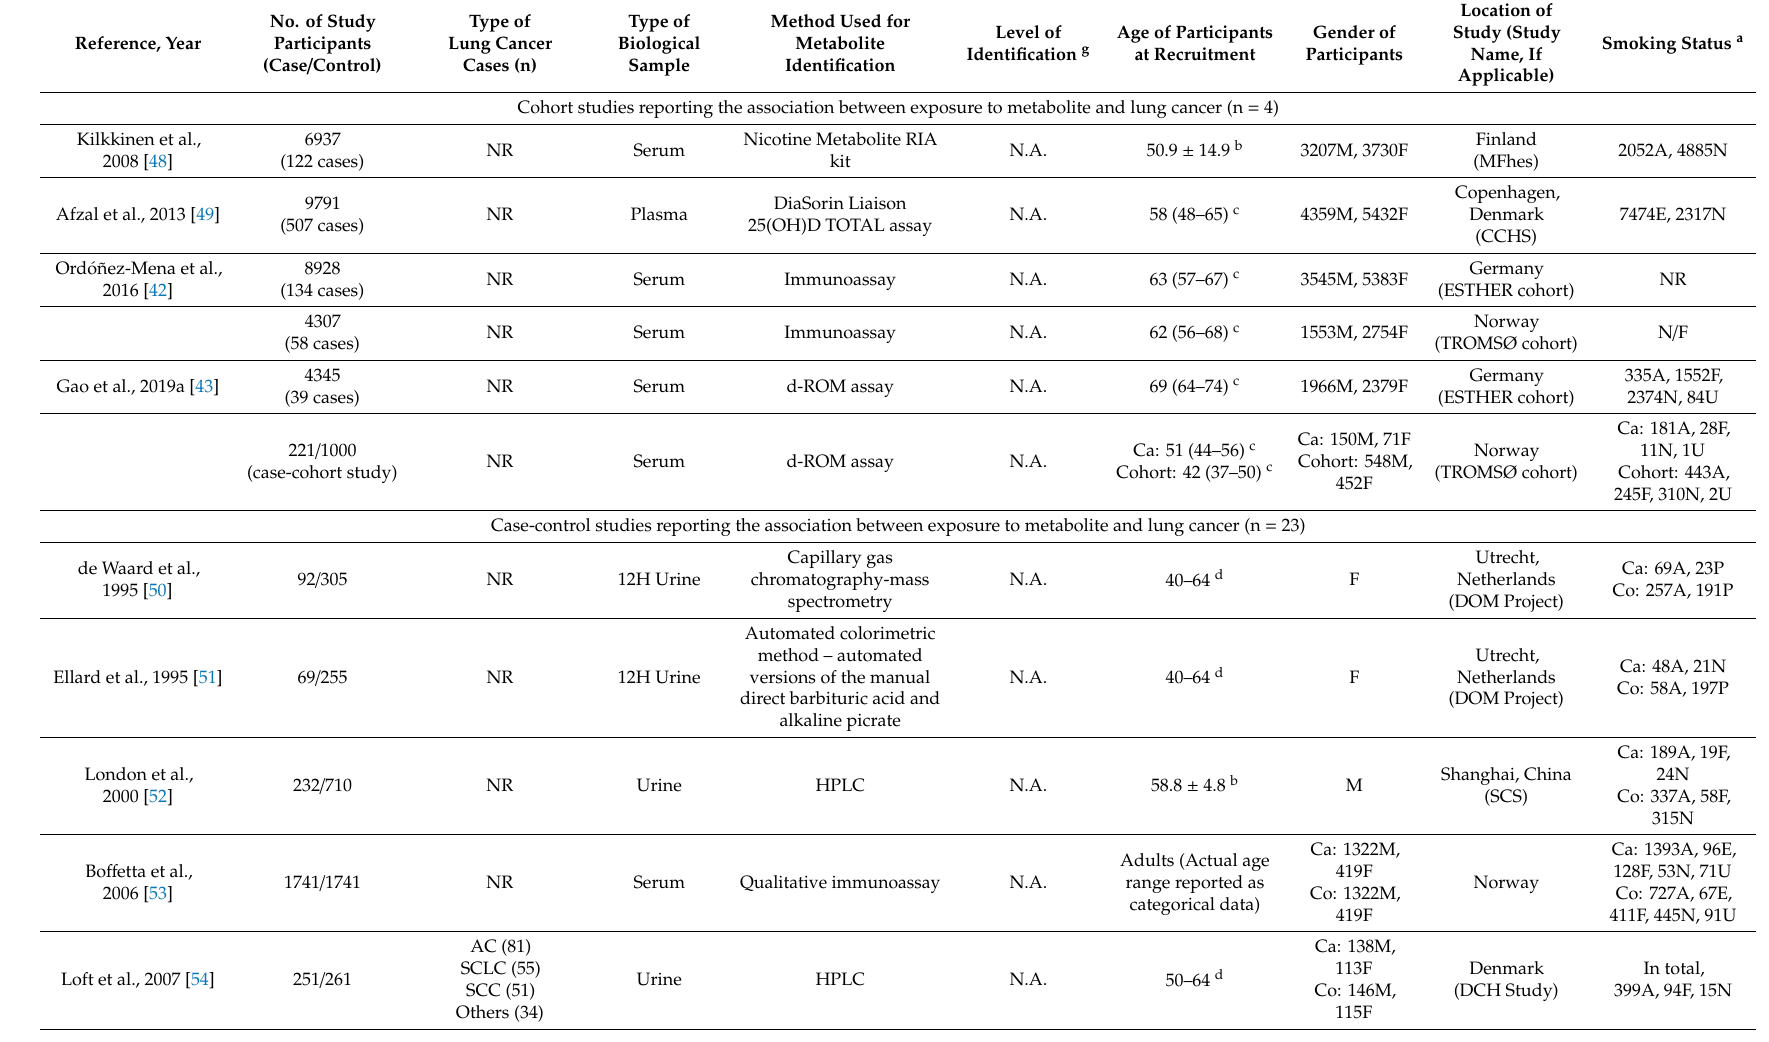
Table 1. Characteristics of included studies (n =